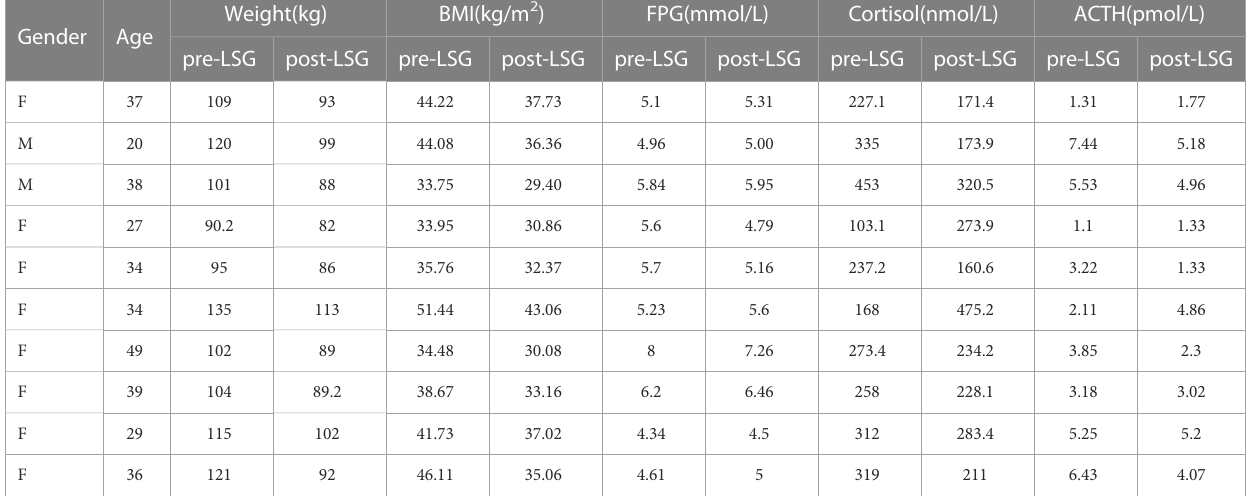
TABLE 1 Characteristics of the studied